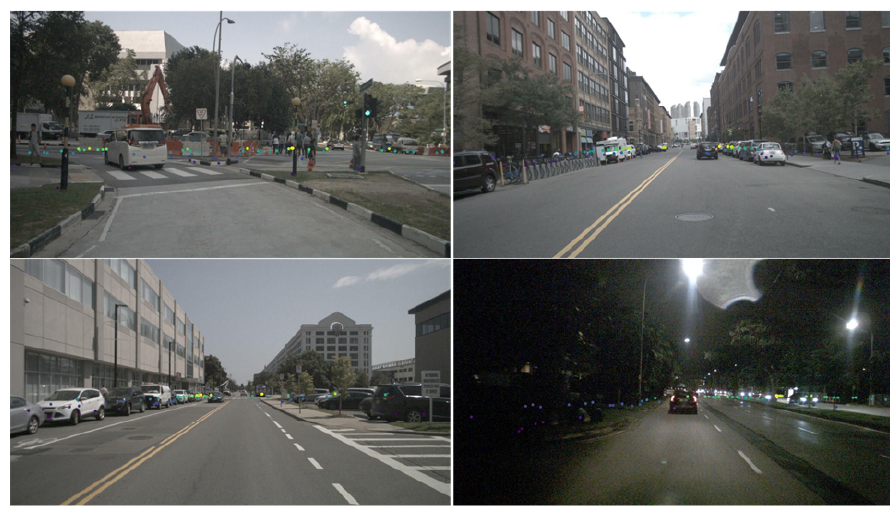
Figure 3. Radar points are projected on the image and rendered into different